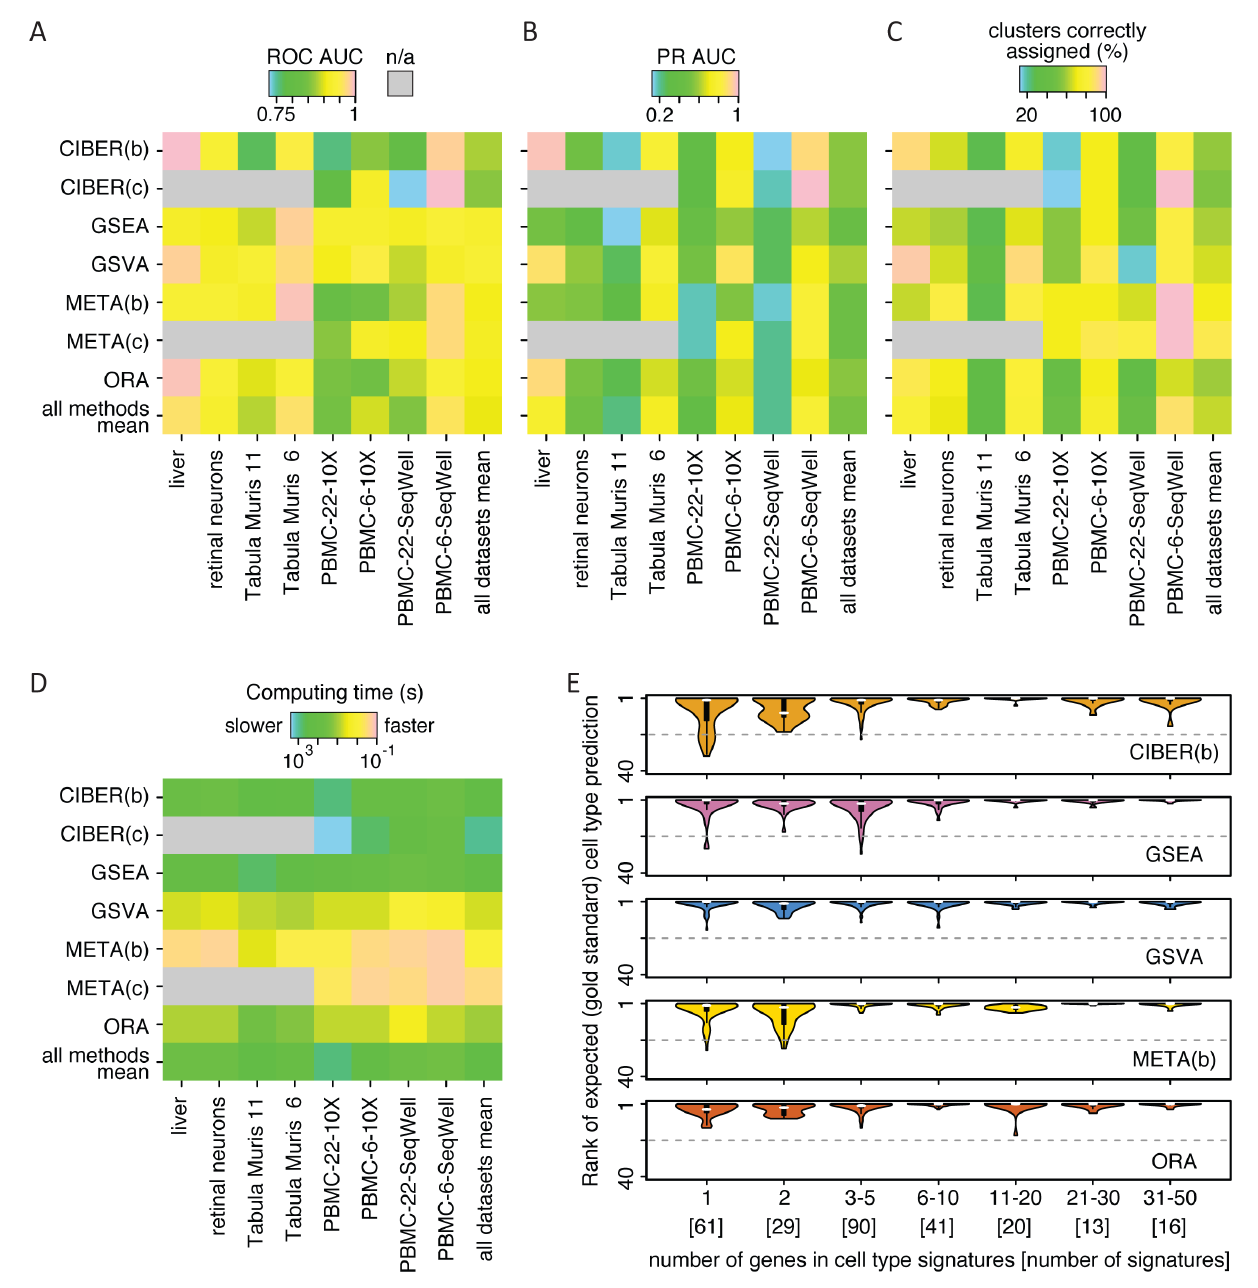
Figure 6. Summary of performance and computing time of cell type prediction methods using scRNA-seq data. ( A ) A heatmap showing a summary of cell type prediction ROC AUCs for the five datasets used (x-axis), including two variants each of the Tabula Muris and PBMC datasets, for the five methods studied (y-axis), including two approaches for CIBERSORT (‘binary’ CIBER(b), and ‘continuous’ CIBER(c)) and METANEIGHBOR (‘binary’ META(b), and ‘continuous’ META(c)). The mean ROC AUCs for each method across all scRNA-seq datasets and for each dataset across all methods are provided. ( B ) A heatmap similar to ( A ), but showing PR AUC values. ( C ) A heatmap showing the percentage of clusters correctly assigned by each method for each dataset. ( D ) A heatmap showing computing times for each cell type prediction task and the mean across all scRNA-seq datasets. Actual values for panels A to D are provided in Supplementary Table 1. ( E ) Violin plots showing the influence of the number of genes in cell type signatures on methods that use gene sets as inputs. The number of genes in the signatures is shown on the x-axis along the number of signatures with that number of genes, in brackets. The rank of the expected (gold standard) predictions is shown on the y-axes. A perfect method would show its gold standard predictions ranked as